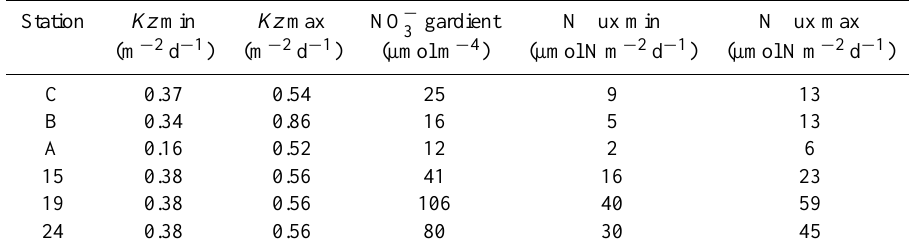
Table 3. Vertical eddy diffusivity coefficient ( Kz , in m − 2 d − 1 ) measured by Cuypers et al. (2011) at every LD station using a SCAMP microprofiler ( Kz values given for stations 15, 19 and 24 are estimated as the average Kz of all stations), NO − gradient at the nitracline 3 (µmolNm − 4 ) calculated by Moutin et al. (2011), and resulting vertical NO − flux (µmolNm − 2 d − 1 ) . Those fluxes have been calculated at 3 the base of the euphotic zone (see Moutin et al., 2011 for euphotic layer depths). Station